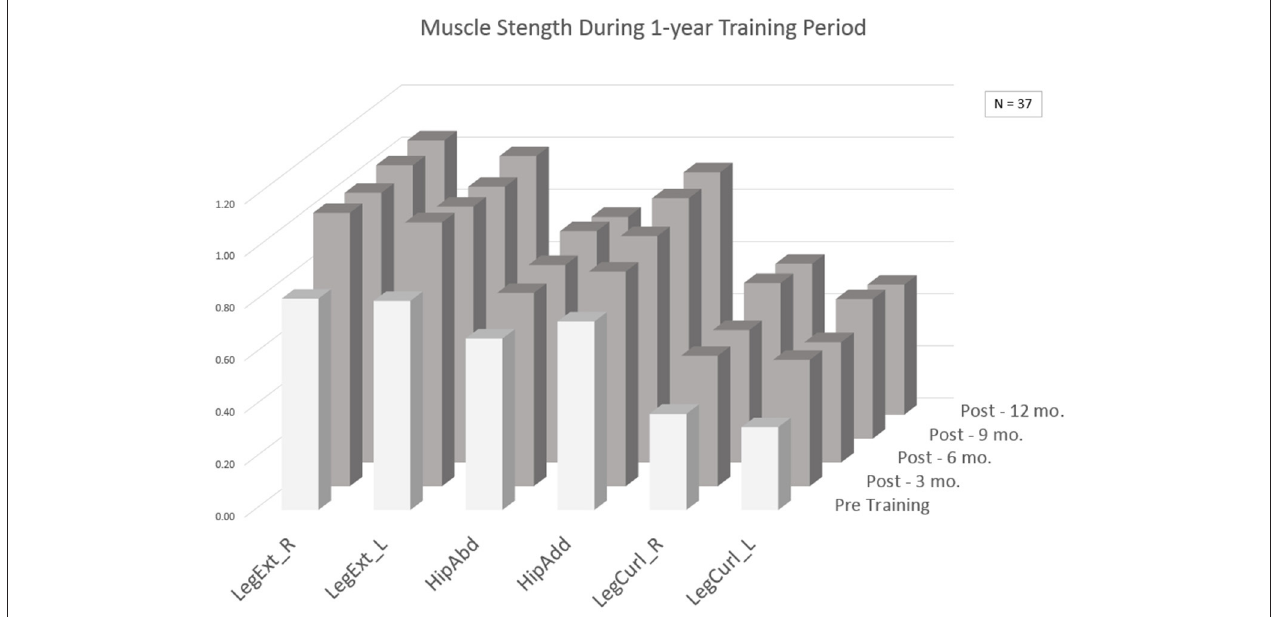
FIGURE 3 | Post-pre change in terms of improvement rate calculated as mean (post-pre)/mean (pre) for Right Leg Extension and Curl strength for Gym Tonic ( N = 399) and “reference” groups and averaged over gender. AGEILITY ( N = 12) and FIN80 ( N = 28) were tightly supervised exercise groups.